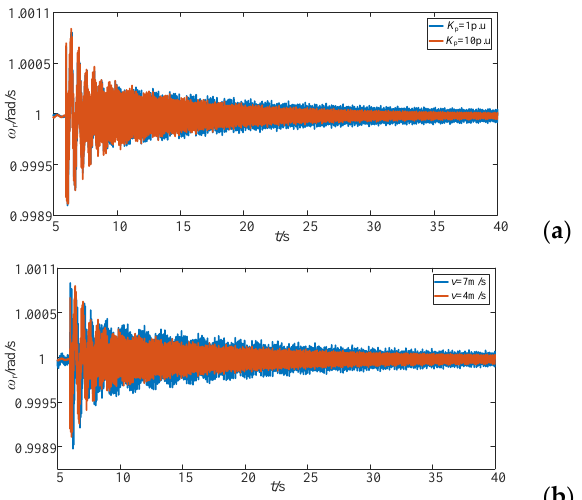
Figure 13. Rotor speed response of SG: ( a ) K p = 1 p.u–10 p.u; ( b ) v = 7 m/s–4 m/s .